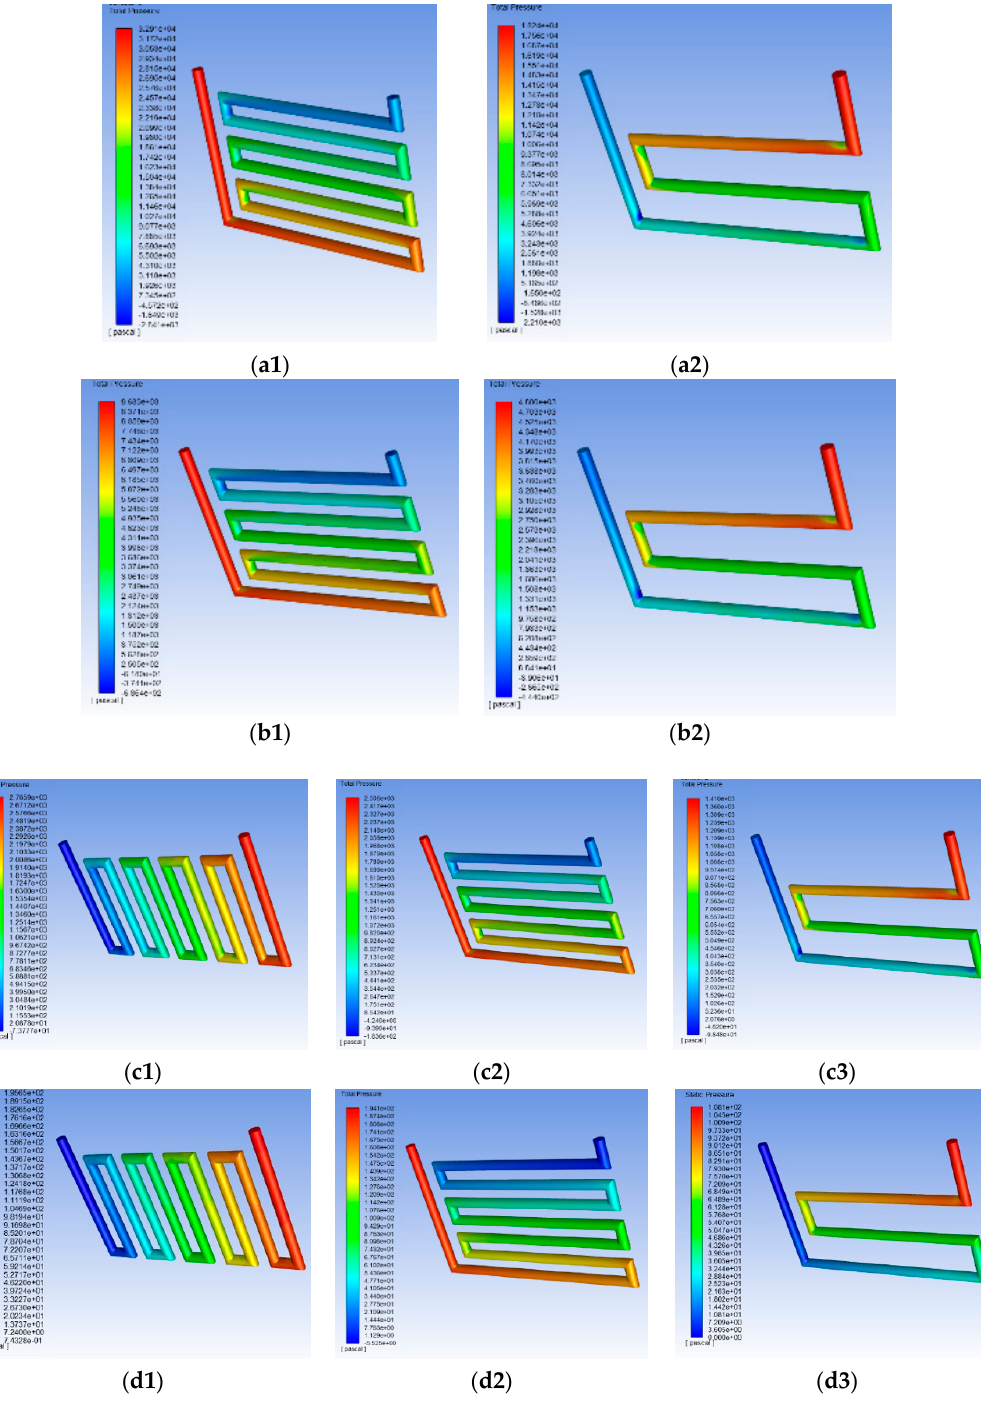
Figure 3. ( a1 ) pressure distribution for case B and V = 2m/s , ( a2 ) pressure distribution for case C and V = 2 m/s , ( b1 ) pressure distribution for case B and V = 1m/s ,( b2 ) pressure distribution for case C and V = 1m/s, ( c1 ) pressure distribution for case A and V = 0.5 m/s ,( c2 ) pressure distribution for case B and V =0.5 m/s, ( c3 ) pressure distribution for case C and V = 0.5 m/s, ( d1 ) pressure distribution for case A and V = 0.1 m/s ,( d2 ) pressure distribution for case B and V = 0.1 m/s ,( d3 ) pressure distribution for case C and V= 0.1 m/s.